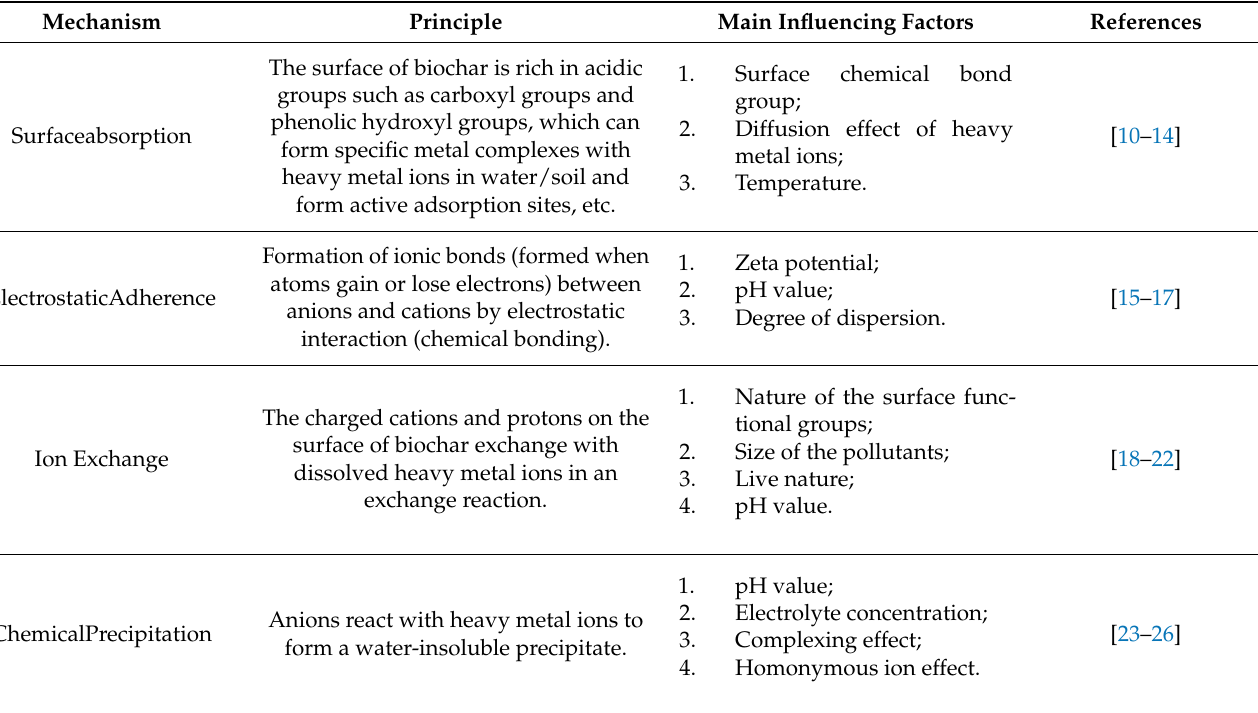
Table 1. Adsorption mechanism of heavy metals by biochar and modified